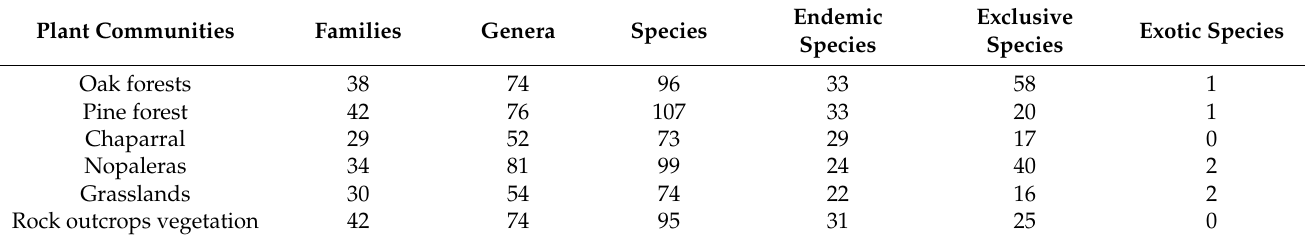
Table 4. Summary of the number of species, family, and genus richness, as well as introduced, endemic and exclusive species by plant community in the Sierra de los Cardos, Susticac á n, Zacatecas, Mexico. Plant